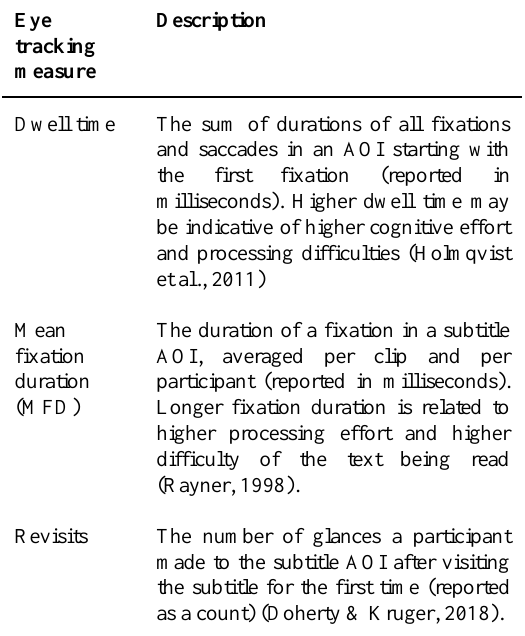
Table 2. Description of the eye tracking